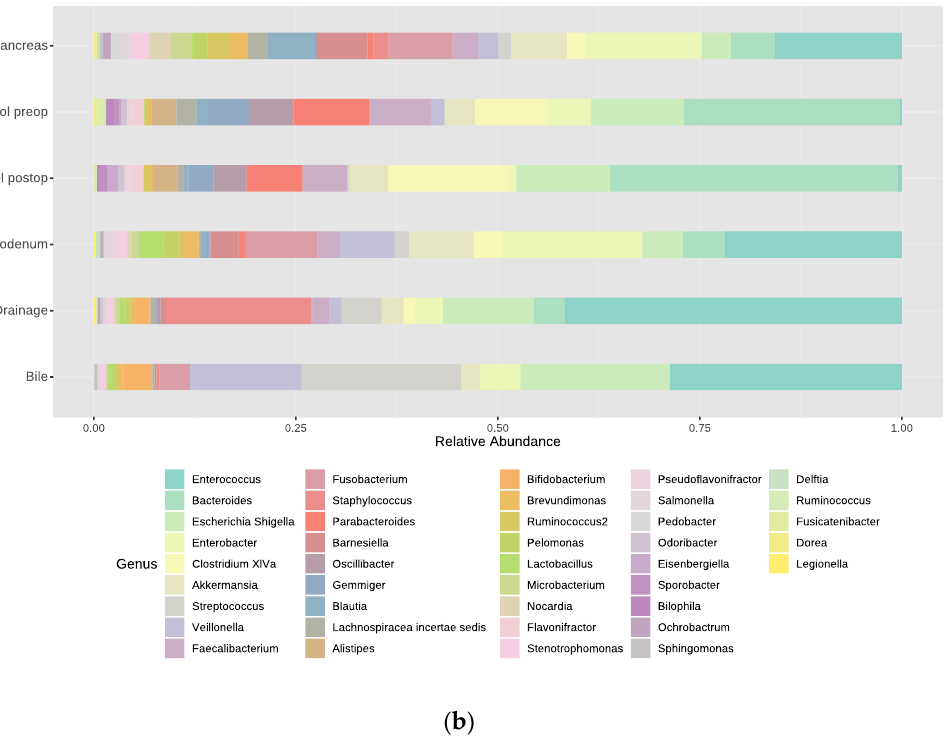
Figure 2. Relative abundance of bacterial taxa in the sampled compartments. ( a ) Taxonomic assignments are shown at the level of the phylum; ( b ) Taxonomic assignments are shown at the level of the genus.